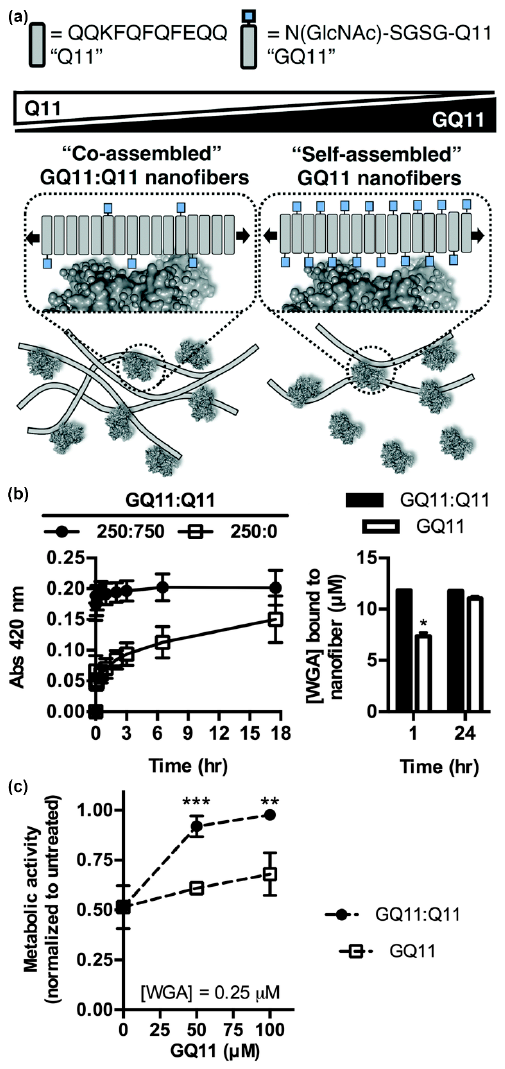
Figure 5. Influence of carbohydrate density and valency on lectin binding to glycopeptide nanofibers. ( a ) Schematic representation of self-assembled glycopeptide nanofibers with different carbohydrate densities and their potential interaction pattern with proteins. Bound proteins are expected to hide neighboring ligands on nanofibers with high carbohydrate density. ( b ) Turbidity (left) and co-precipitation assays (right) demonstrate that wheat germ agglutinin (WGA) binds faster to GlcNAc-Q11 and Q11 (1:3 ratio) mixed nanofibers (moderate density) compared to pure GlcNAc-Q11 nanofibers (high density). * represents p < 0.005, Student’s t-test. ( c ) Nanofibers with optimal carbohydrate density inhibited WGA-induced Jurkat T-cell death more effectively than nanofibers with high carbohydrate density. ** represents p < 0.01 and *** represents p < 0.001, Student’s t -test. Reproduced from reference [96] with permission from The Royal Society of Chemistry.